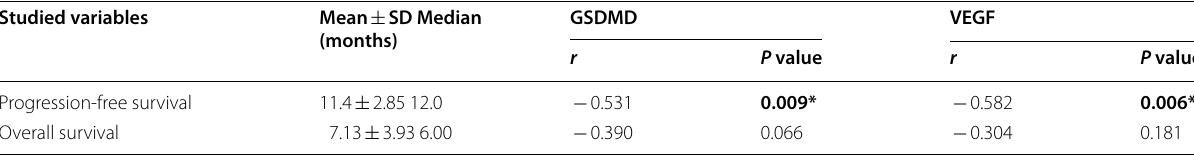
Table 7 Correlation between GSMD and VEGF with Progression‑free survival and Overall survival among malignant pleural effusion